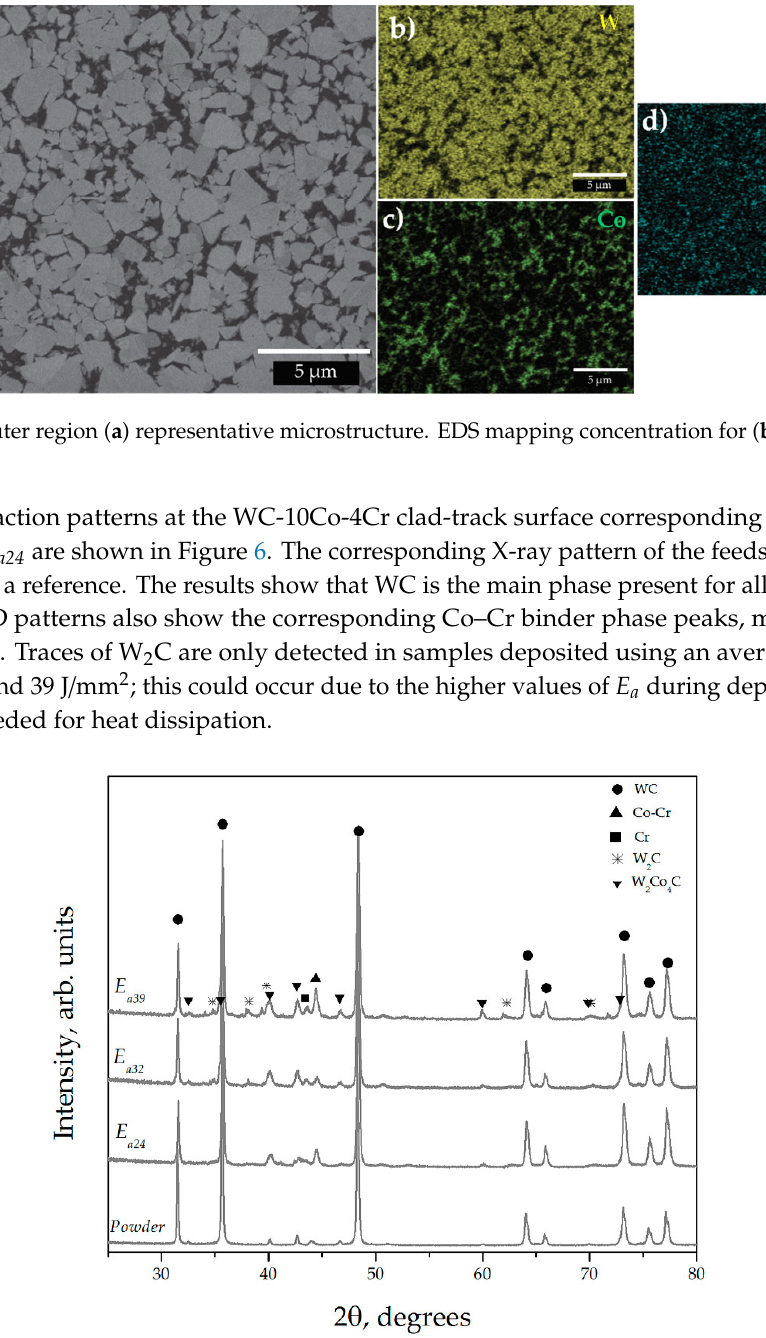
6 of 14 Figure 4. ( a ) Representative microstructure of the interface region; EDS mapping concentration for ( b ) Fe, ( c ) Co, ( d ) Cr and ( e ) W, for sample E a39 . An EDS-mapping analysis conducted on the interface is shown in Figure 4b–e. The Fe-map distribution (Figure 4b) within the interface logically resulted owing to a proper mixing with the substrate chemistry. Indeed, the concentration of Fe is higher next to the substrate and this is reduced if moving towards the coating interior. On the other hand, Co and Cr (Figure 4c,d) are properly mixed along with the interface. By comparing Figure 4b or Figure 4e; there exists a rich region containing a large amount of W areas which corresponds to the bright particles (labeled as E) observed in Figure